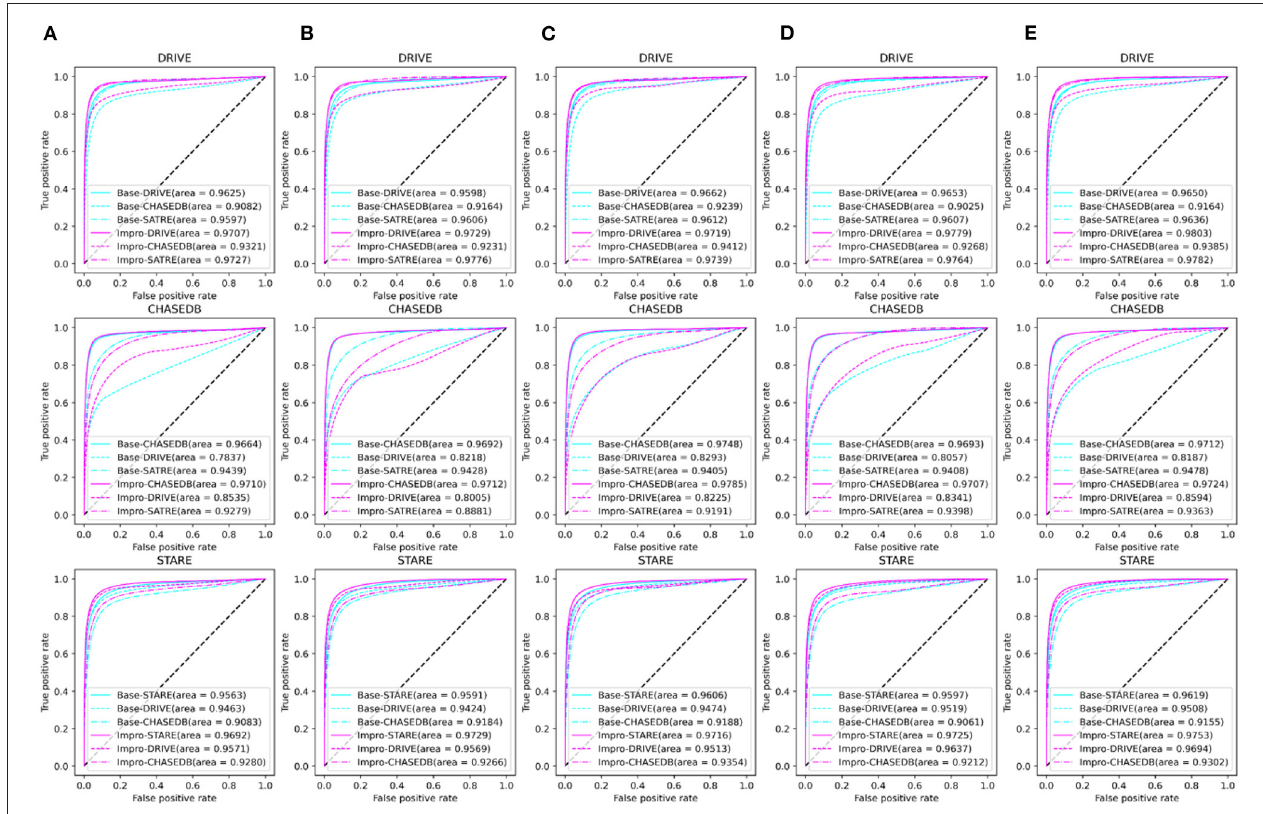
FIGURE 11 | Comparison of the domain adaptability based on the AUC: (A) 5-way 3-shot; (B) 4-way 3-shot; (C) 3-way 3-shot; (D) 3-way 4-shot; and (E) 3-way 5-shot.